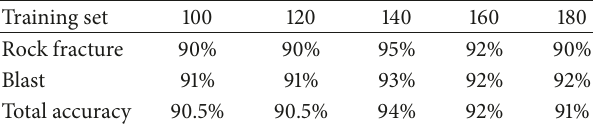
Table 5: Classification accuracies with different training numbers. Training